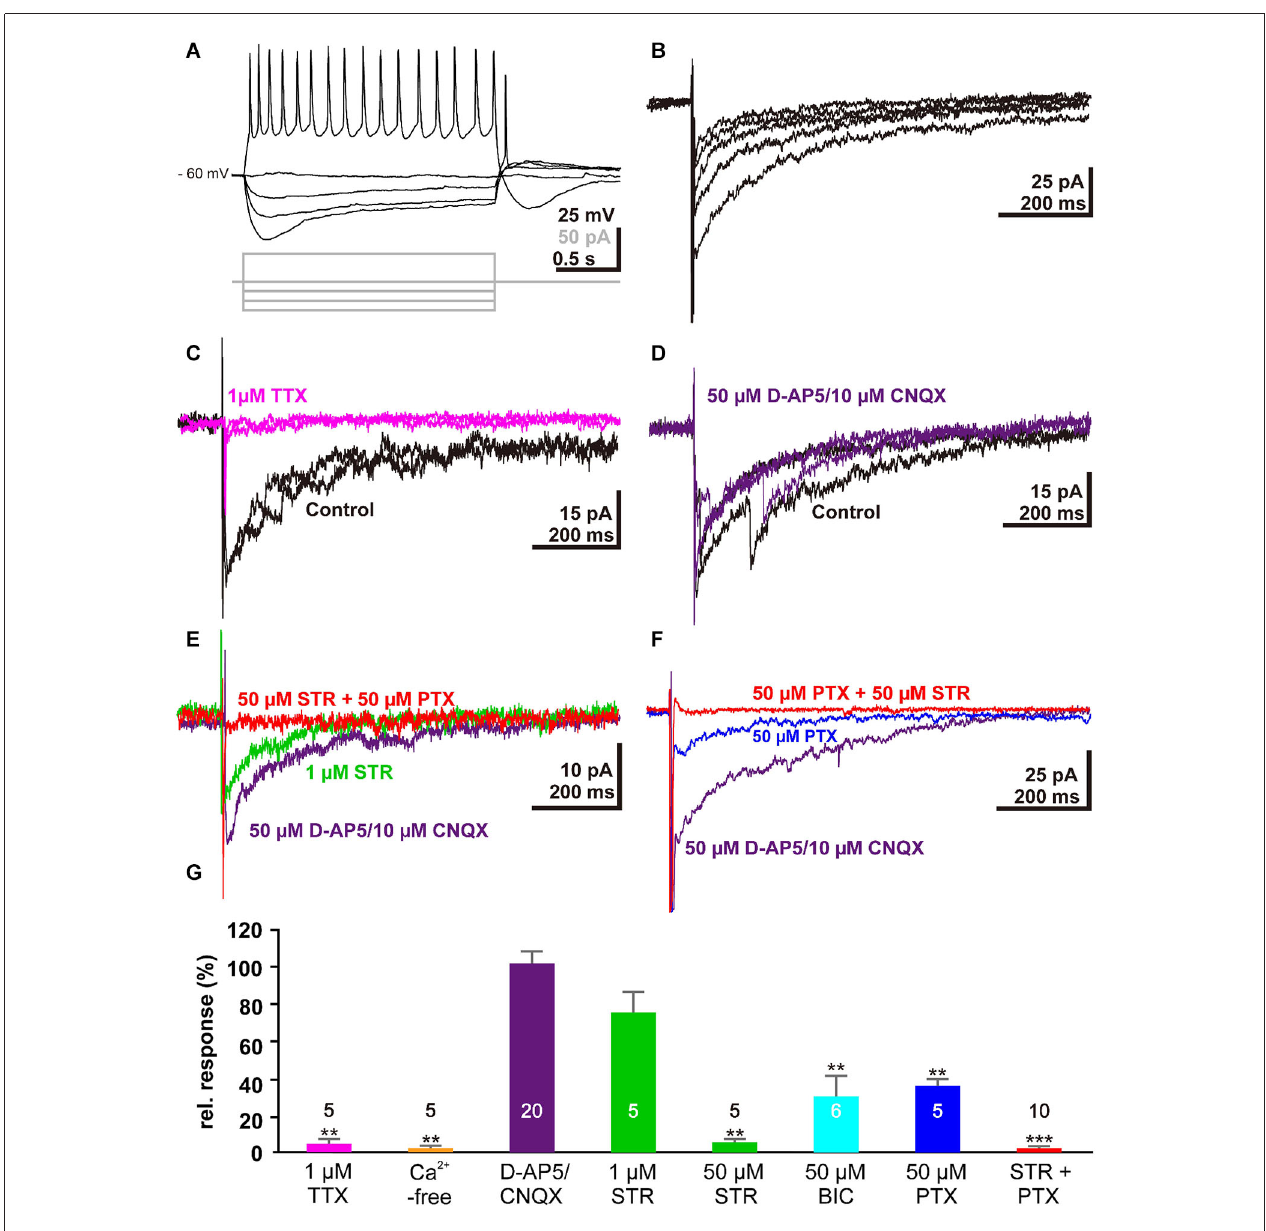
unaffected in the presence of 50 µ M D-AP5 and 10 µ M CNQX (purple trace). (E) The stimulus-induced inward current was reduced in the presence of 1 µ M STR (green trace) and was abolished when both GABA A and glycine receptors were blocked with 50 µ M STR and 50 µ M PTX, respectively (red trace). (F) The stimulus-induced inward current was reduced in the presence of 50 µ M PTX (blue trace). (G) Statistical analysis. Bars represent the mean ± SEM, numbers of experiments are given in the